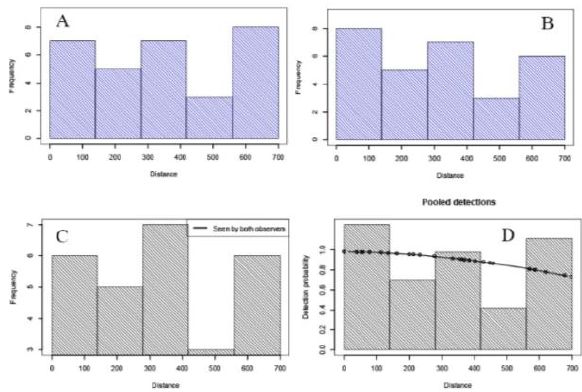
Figure 12. Scaled histograms of perpendicular distances and the predicted detection probability functions for pilot whale groups. A) Front observers, B) rear observers, C) both observers and D) pooled detections with sightings fitted to a half-normal model where each observation prediction is shown as a circle. Distance is measured in meters from the line directly below the aircraft.